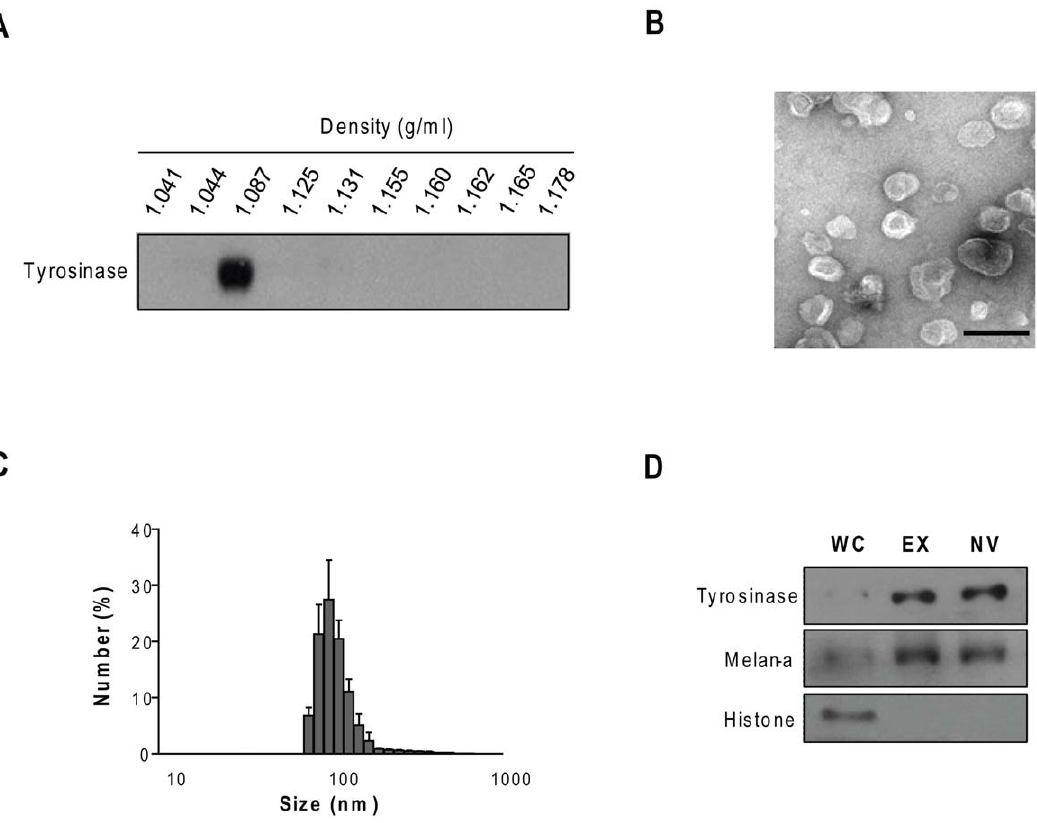
Figure 1. Preparation and characterization of tumor-derived NVs. A. Western blot analysis of the melanoma antigen tyrosinase in fractions of tumor-derived NVs obtained from the Optiprep density gradients. The density of each fraction was determined by measuring absorbance at 340 nm. B. Transmission electron micrograph of the NVs prepared from autologous melanoma tissues. Bar, 200 nm. C. Size distribution of NVs, measured by dynamic light-scattering, shows a diameter range of 80–150 nm. D. Western blot detection of tyrosinase, melan-A, and histone in 10 m g of whole cell lysate (WC), exosomes (EX), and NV.